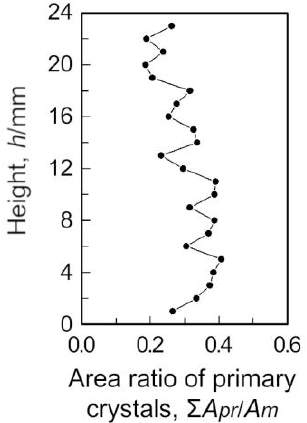
Figure 8. Close-up microscopic image of a cell wall. ( a ) Four types of primary crystals are indicated by the arrows. The first arrow indicates a grained primary crystal. The second arrow indicates a conjoined grain primary crystal. The third arrow indicates a dendrite crystal grown from a grained primary crystal. The fourth arrow indicates dendrite crystals existing alone. ( b ) Microstructure after etching by Weck’s reagent. The yellow arrow indicates the segregation part during water cooling process.